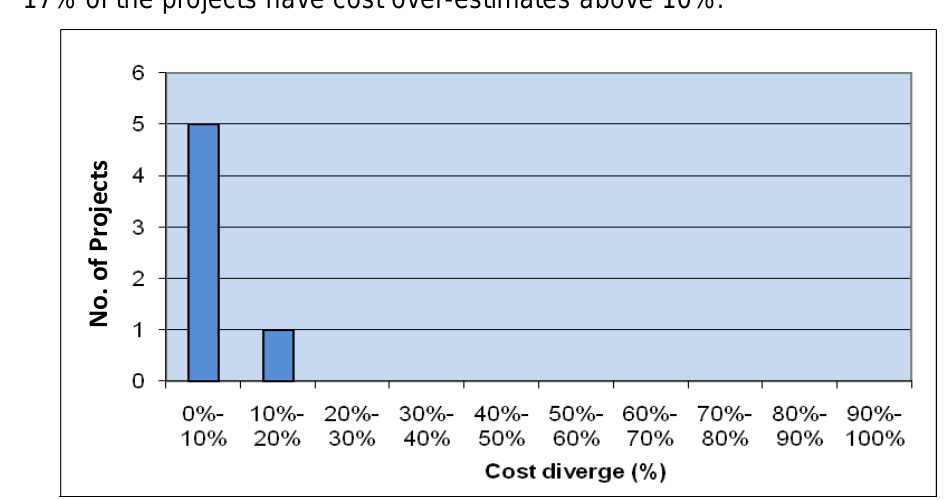
Figure 8 Cost over-estimates vs. no of projects in medium sized road construction projects